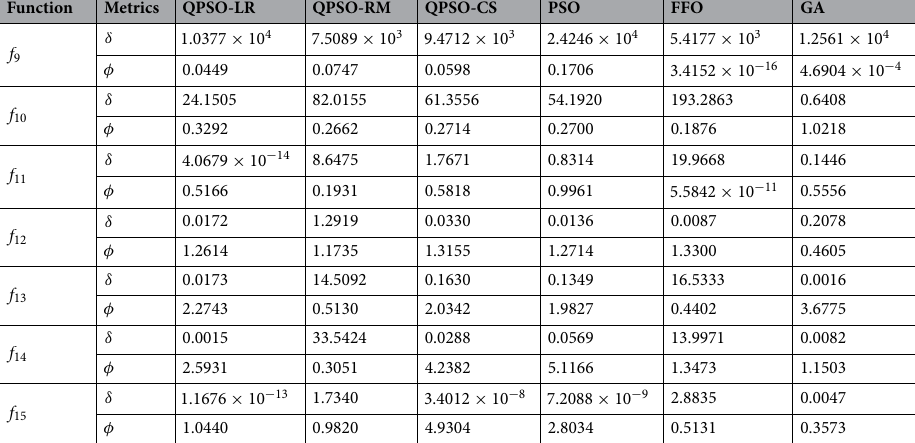
Table 2. Accuracy and precision metrics for multimodal benchmark functions with N = 30, Tmax = 1000 and Texp = 30.